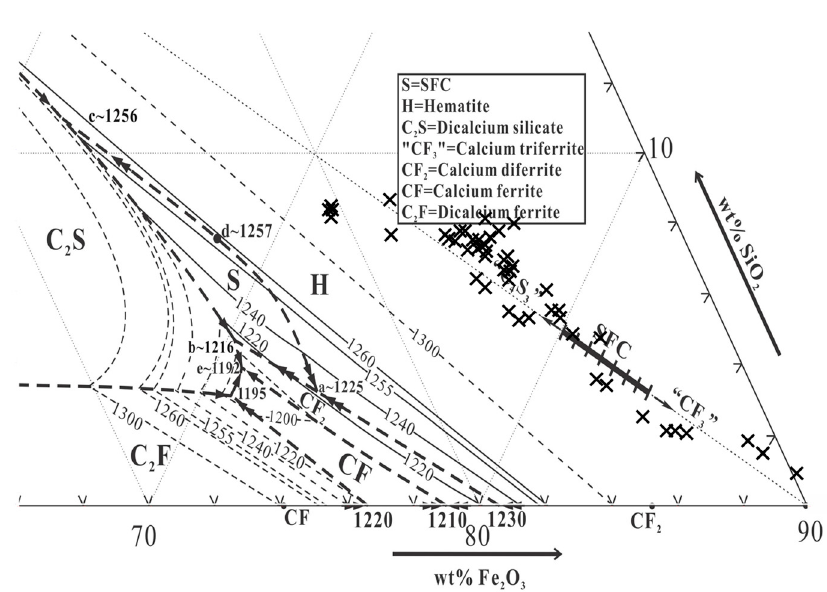
Figure 15. SFCA composition, as measured by EPMA, projected onto the “Fe 2 O 3 ”–CaO–SiO 2 ternary system [12] assuming the Al 2 O 3 → Fe 2 O 3 and MgO → CaO exchange consistent with the formation of CF 3 -C 4 S 3 solid solution (X-SFCA composition).